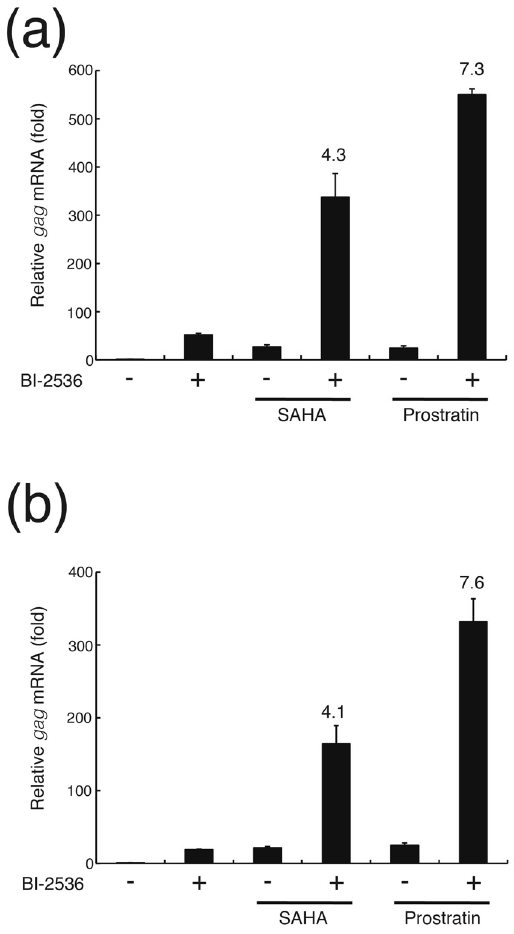
Figure 8. BI-2536 synergistically reactivates latent HIV-1 provirus with SAHA or prostratin in ACH2 and U1 cells. ( a ) ACH2 and ( b ) U1 cells were treated without ( − ) or with ( + ) 0.1 μ M BI-2536 in combination with 1 μ M SAHA or 0.25 μ M prostratin for 16 hours. HIV-1 gag mRNA expression was measured by quantitative RT-PCR. Fold induction of gag mRNA normalized by gapdh mRNA expression was determined compared with untreated cells. Each value is shown as a mean ± standard deviation (SD) of triplicate determinations. The values of fold synergy are shown above the bars representing BI-2536 + SAHA and BI-2536 + prostratin. The fold synergy was determined by dividing the fold induction observed in combination treatment with the two inhibitors by the sum of the fold inductions observed in treatment with each of the inhibitors